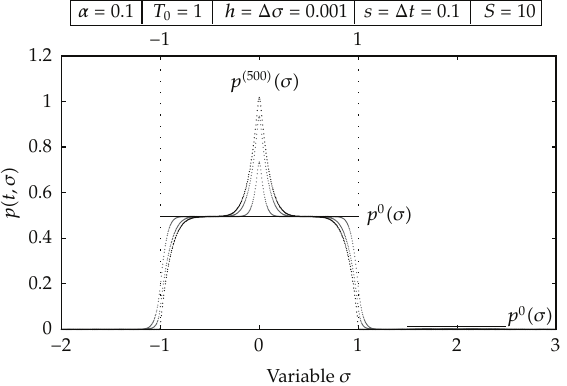
Figure 13: Graphics sequence: Unstable fixed